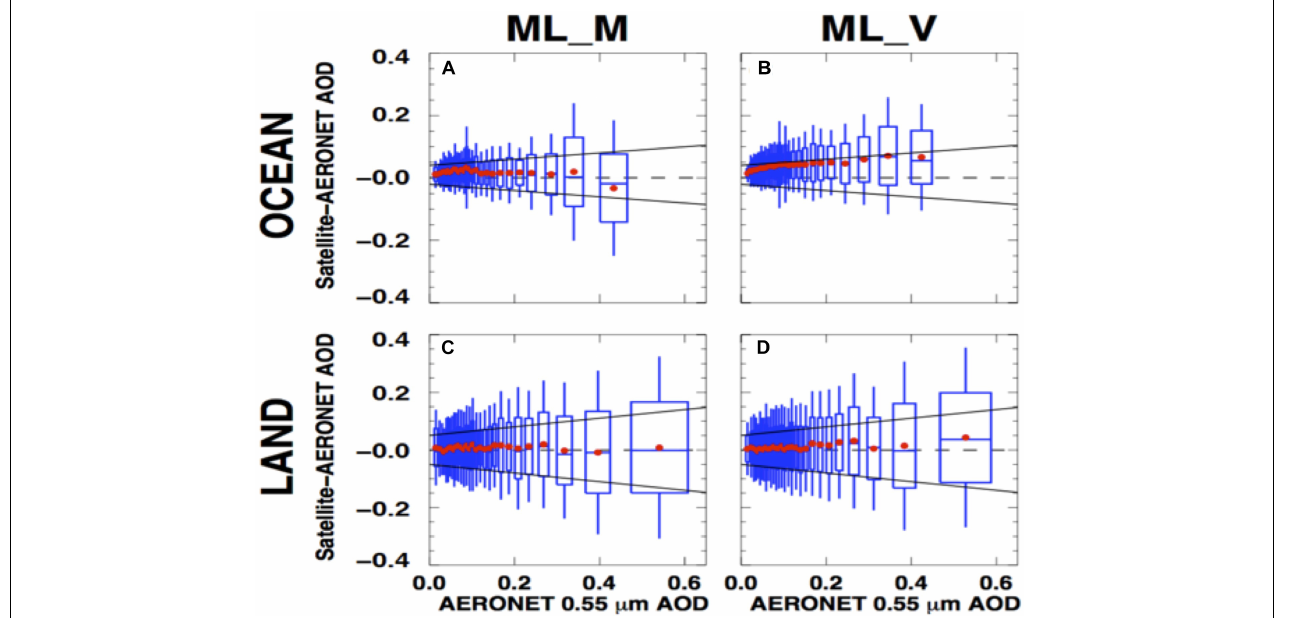
FIGURE 2 | Differences between satellite retrieval of AOD and collocated AERONET measurements of AOD from a global data set of satellite-AERONET collocations, sorted according to AERONET AOD and binned with equal number of collocations in each bin. Red dots indicate mean of each bin, boxes enclose one standard deviation in each bin, whiskers extend to two standard deviations and blue center line of each box denotes the median. (A,C) Is for the MODIS-like retrieval algorithm applied to MODIS input radiances. (B,D) Is for the same MODIS-like retrieval algorithm applied to VIIRS input radiances. (A,B) is for aerosol retrievals over ocean, and (C,D) is for retrievals over land. Reprinted from Levy et al. (2015), under Creative Commons Attribution 3.0